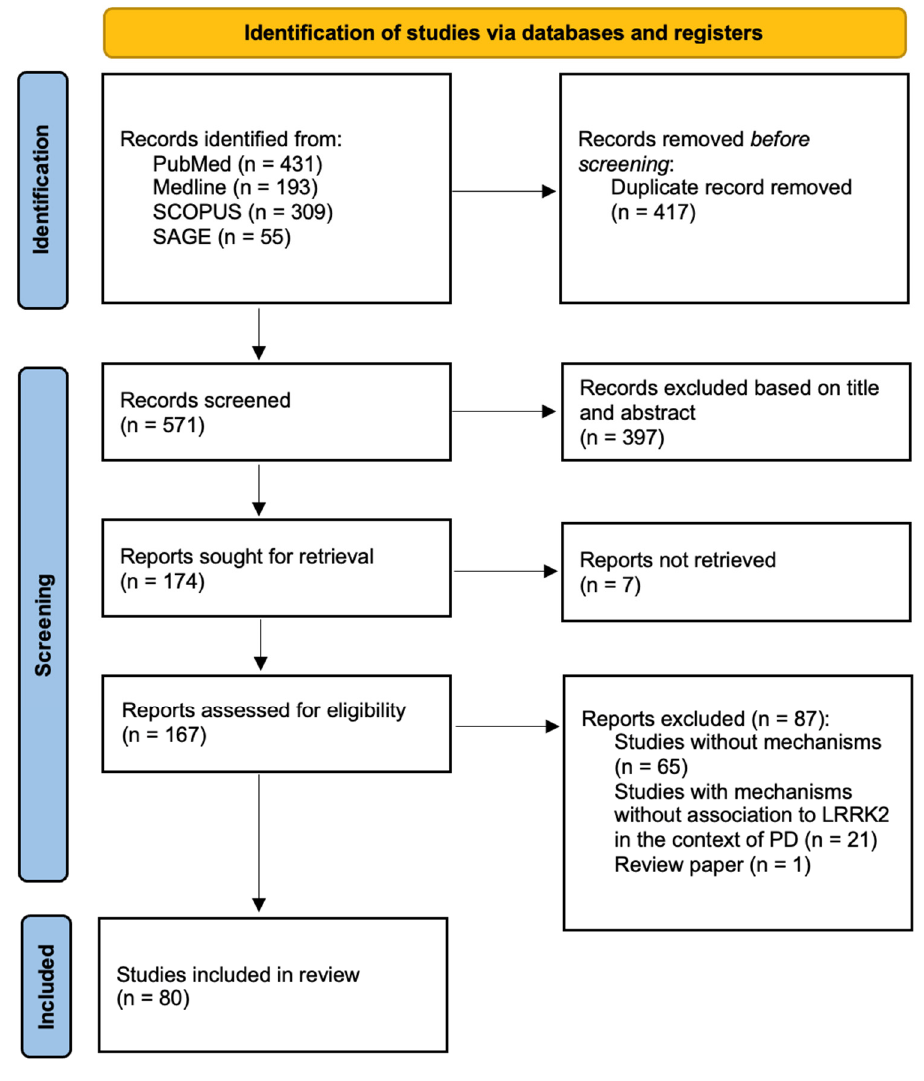
Figure 2. Flow chart of the literature search according to PRISMA guidelines [22].